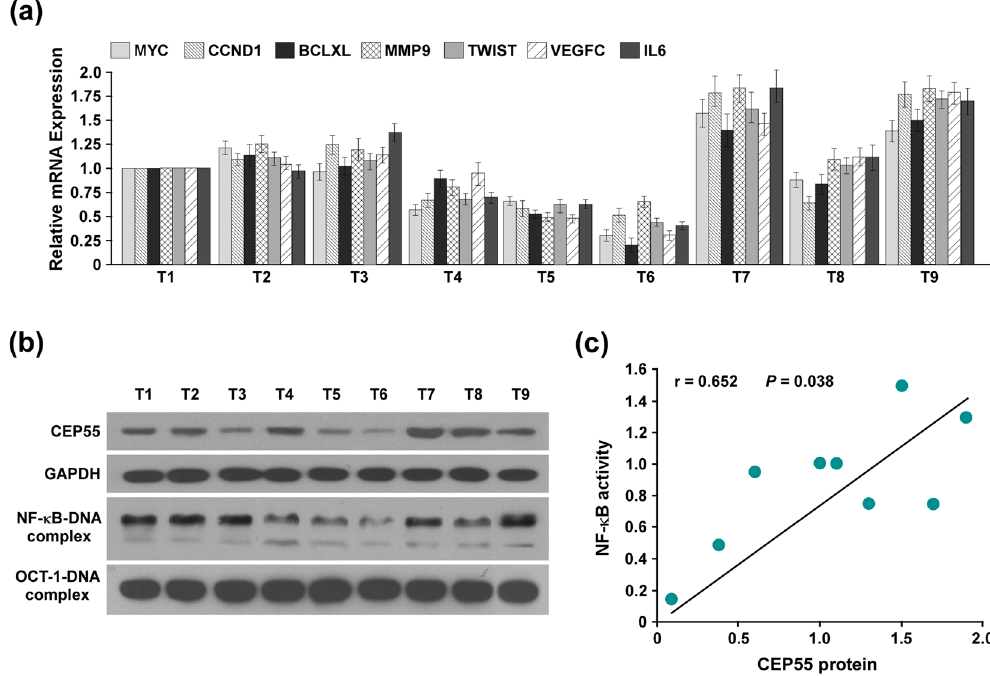
Figure 7. CEP55 expression was clinically correlated with the activation of nuclear factor kappaB (NF- κ B) signalling in patients with pancreatic cancer (PANC). ( a ) Changes in mRNA expression of NF- κ B-regulated genes ( MYC , CCND1 , BCLXL , MMP9 , TWIST , VEGFC and IL6 ) in nine pancreatic cancer tissues assessed by real-time PCR. ( b ) Western blotting analysis of CEP55 expression in these nine pancreatic cancer tissues (Upper panel). The endogenous NF- κ B activity in these nine pancreatic cancer tissues detected by an electrophoretic mobility shift assay (EMSA) (Lower panel). ( c ) The Spearman correlation coefficient was calculated to assess the significance of association between CEP55 protein and NF- κ B activity. * P <